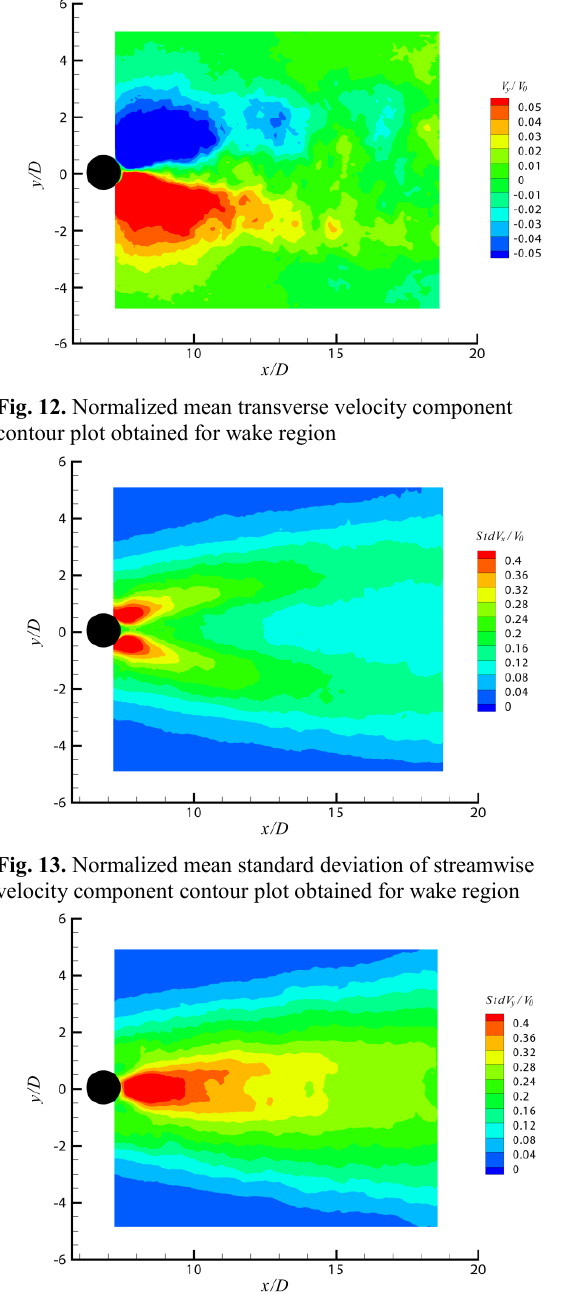
Fig. 14. Normalized mean standard deviation of transverse velocity component contour plot obtained for wake region Normalized velocity value vector contours and vortex visualization at four time steps obtained for wake region are presented on Figures 15-18. Time difference between frames is 0.06 s. Vortex shedding from the outer side of cylinders forms a single vortex